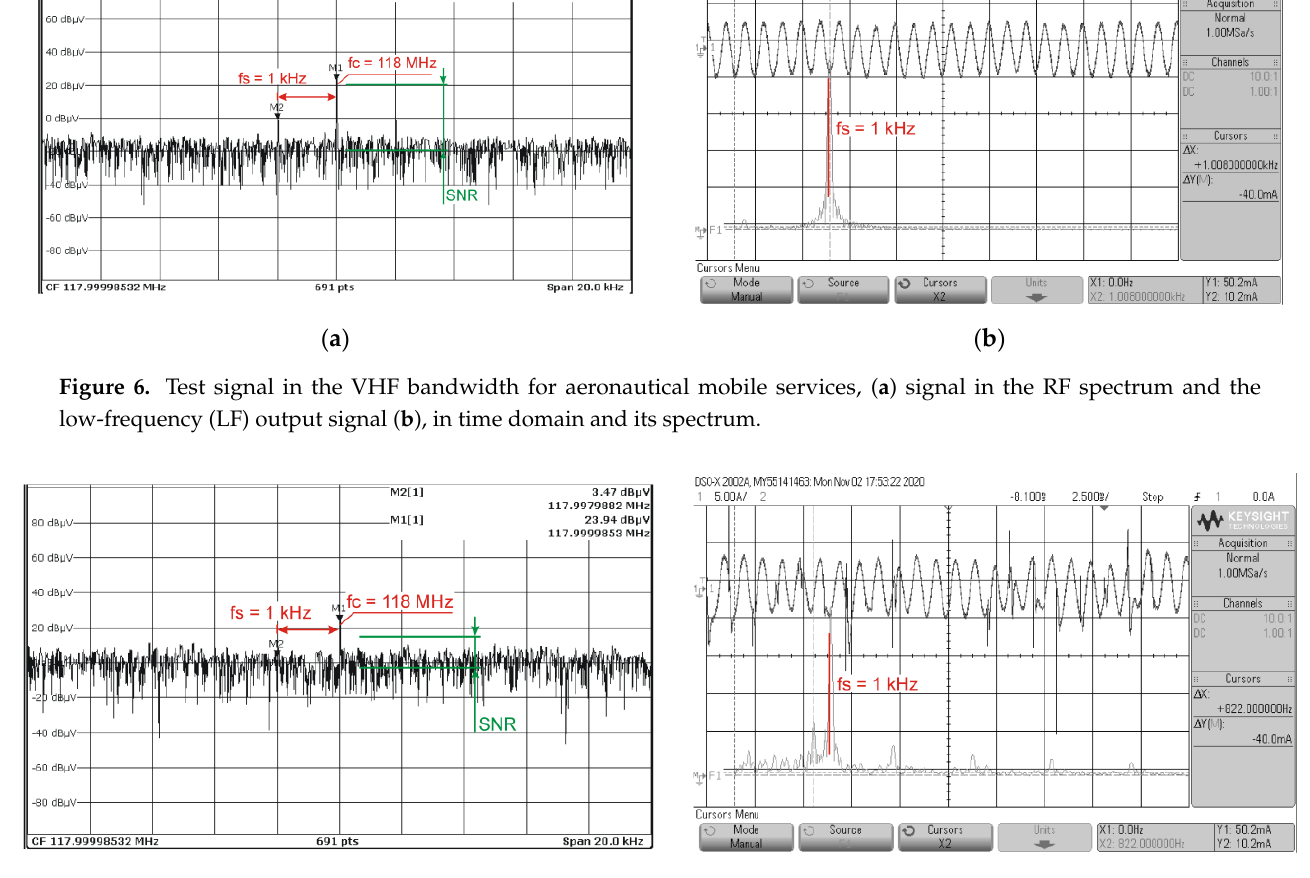
Figure 6. Test signal in the VHF bandwidth for aeronautical mobile services, ( a ) signal in the RF spectrum and the low- frequency (LF) output signal ( b ), in time domain and its spectrum.